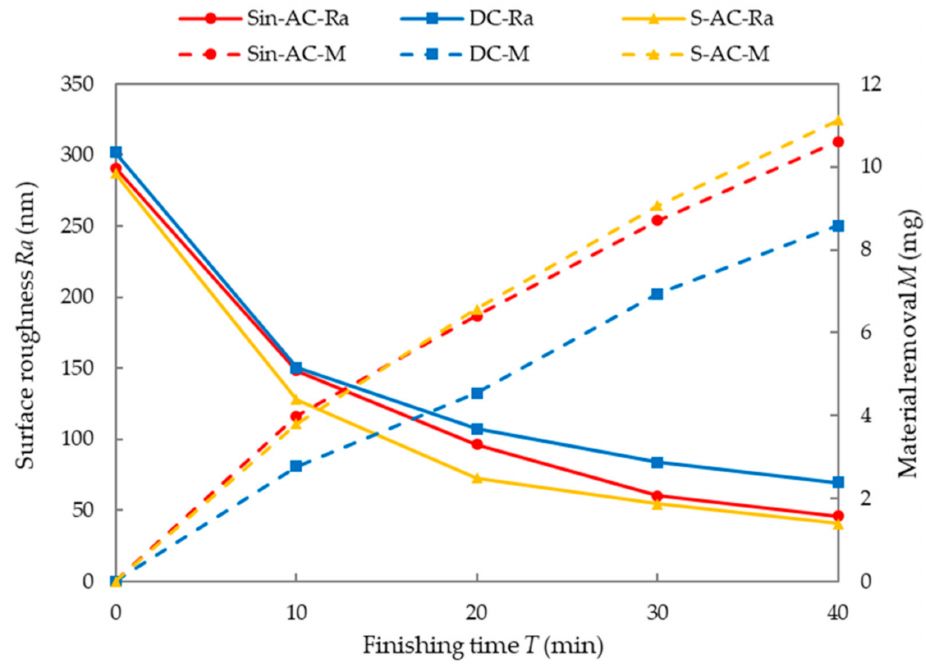
Figure 7. The e ff ect of current waveform on surface roughness and material removal. (Magnetic